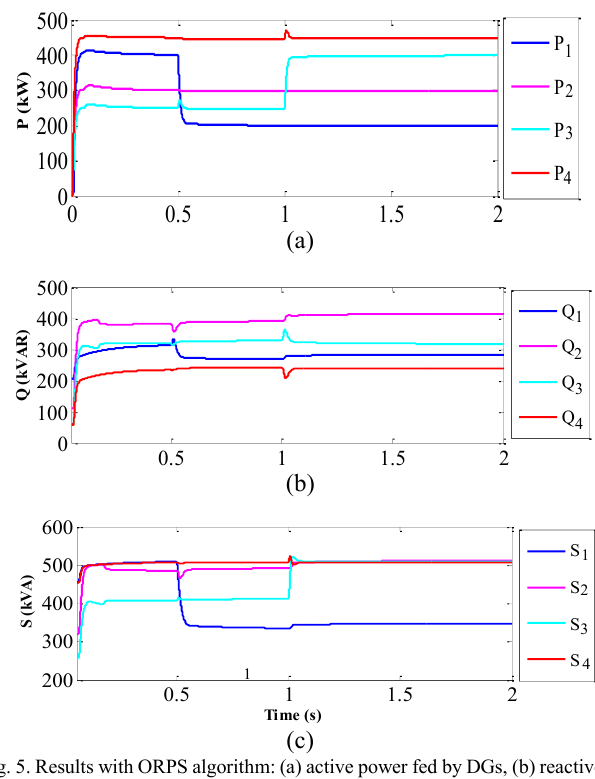
Fig. 5. Results with ORPS algorithm: (a) active power fed by DGs, (b) reactive power shared by the inverters, (c) apparent power of each